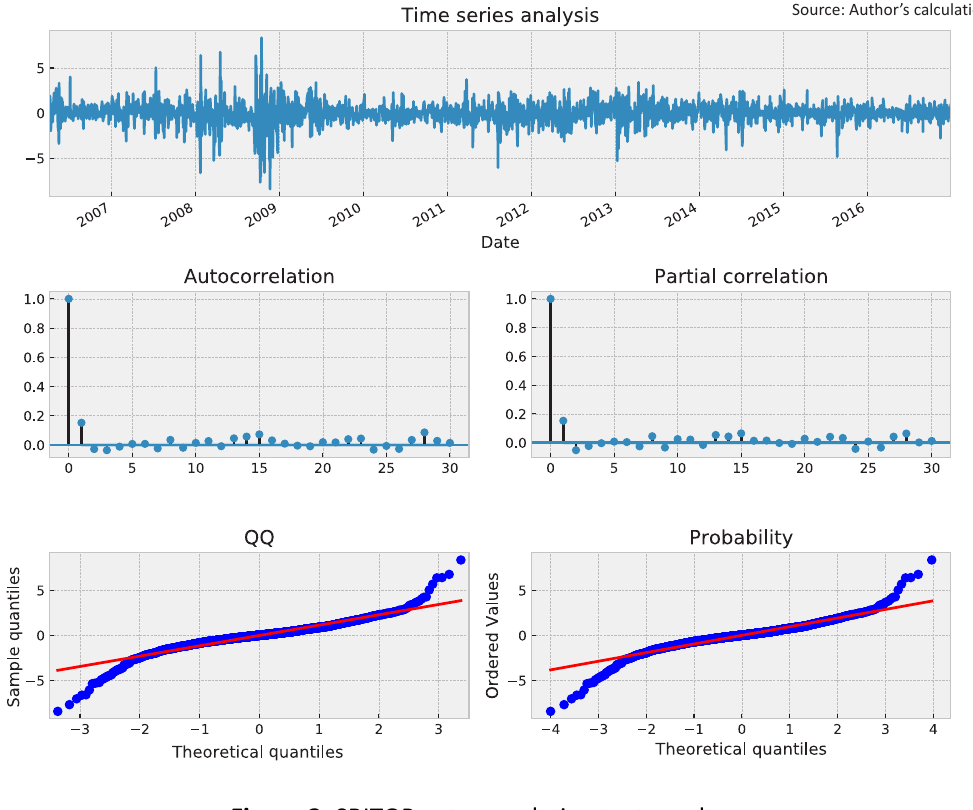
Figure 3. SBITOP autocorrelation test results